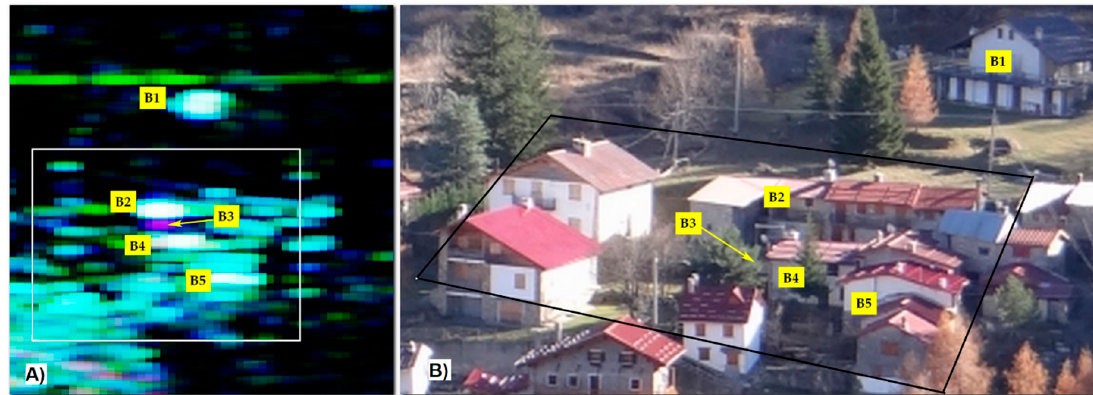
Figure 18. ( A ) Zoomed area of the map of Figure 16a: Houses are labeled to identify them in the corresponding picture. ( B ) The white and black rectangles indicate the area analysed in greater detail in Figure 19.